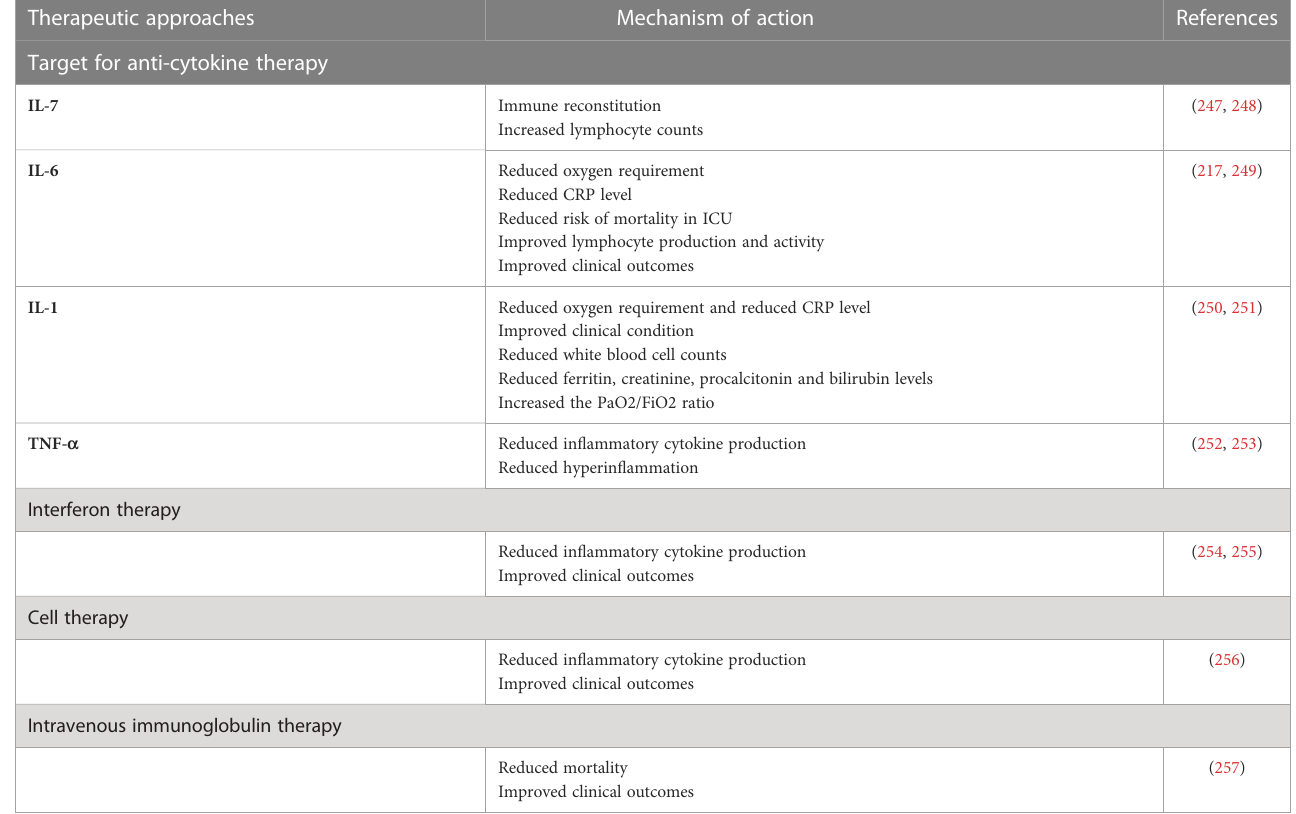
TABLE 1 Therapeutic approaches in